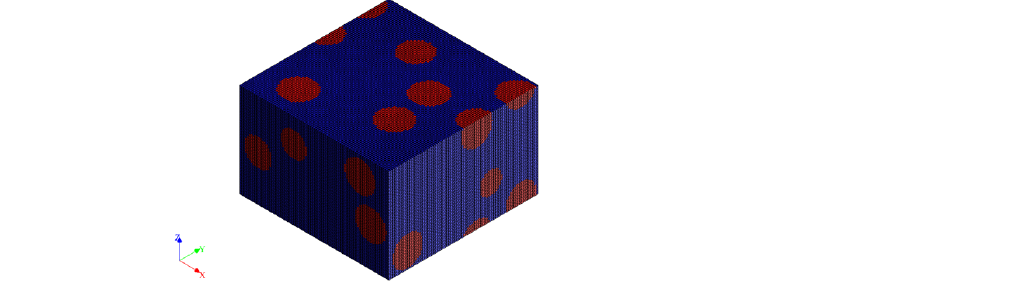
Figure 4. A meshed RVE for 9.5 vol.% Cu and 45 µ m thickness for the Cu-PU film composite. The red dots are the Cu particles and dark blue is PU matrix. Table 2. Physical properties of the components of Cu-PU film composite [49]. Material